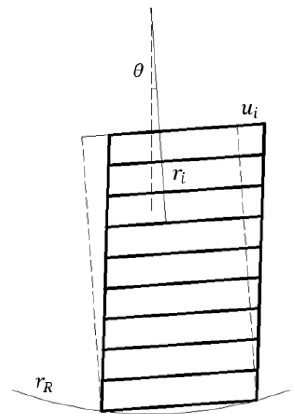
Figure 4. Isolation structure equipped with SLDRFPB.